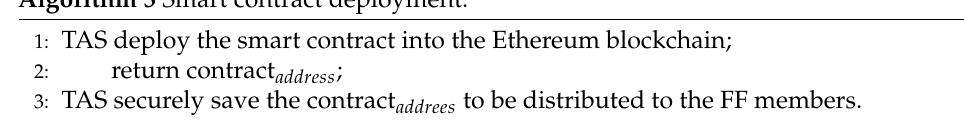
Algorithm 5 Smart contract deployment.